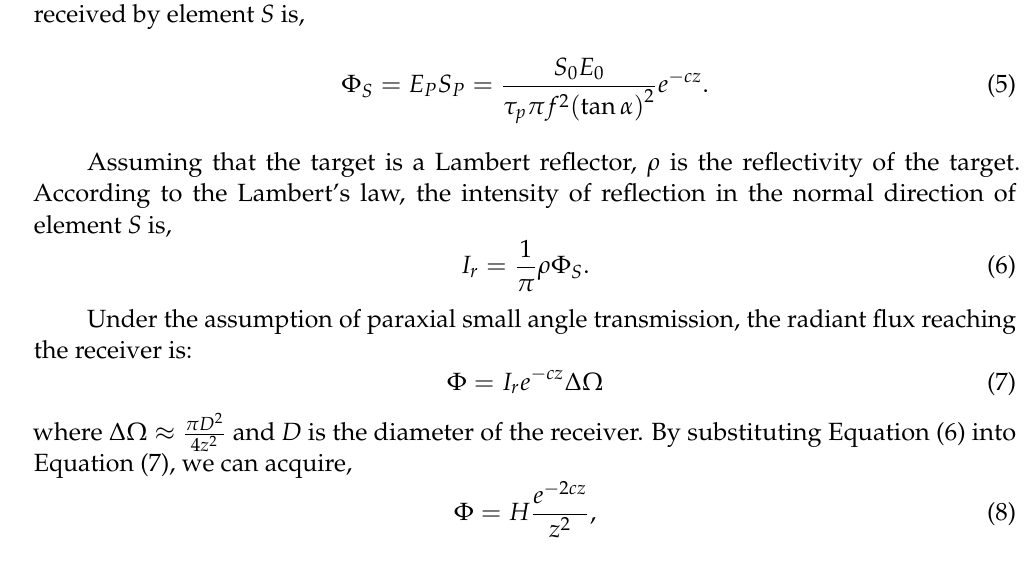
Figure 4. Coordinate system of PLRGI system.